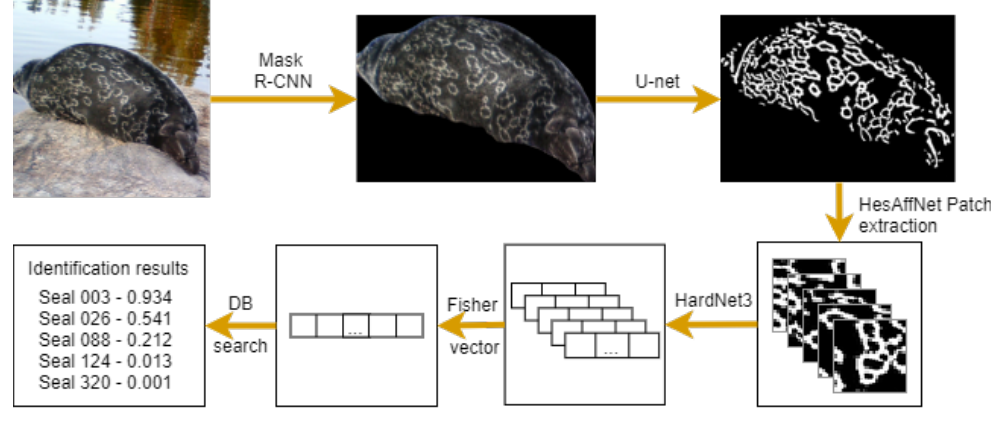
Figure 7. NORPPA re-identification pipeline